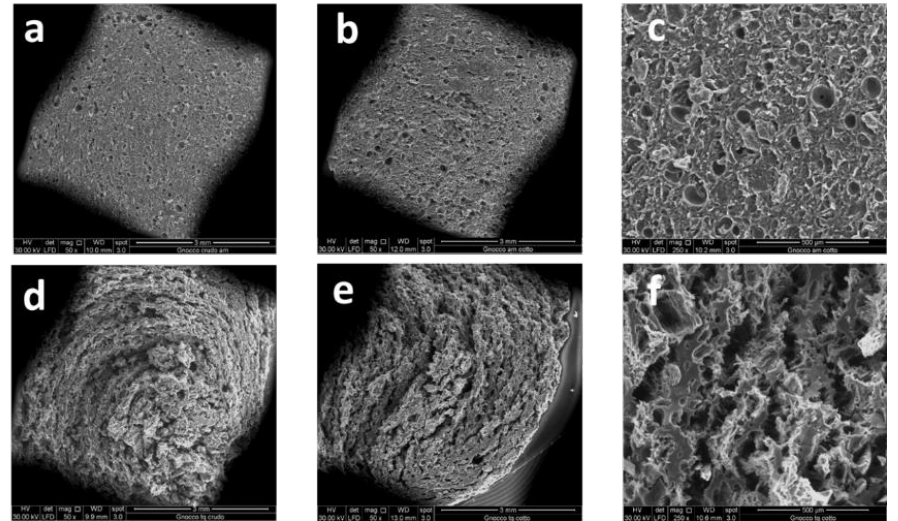
Figure 3. SEM micrographs of Gnocchi fractured surfaces: raw ( a ) and cooked in saline water ( b , c ) and raw ( d ) and cooked in tap water ( e , f ). and raw ( d ) and cooked in tap water ( e , f